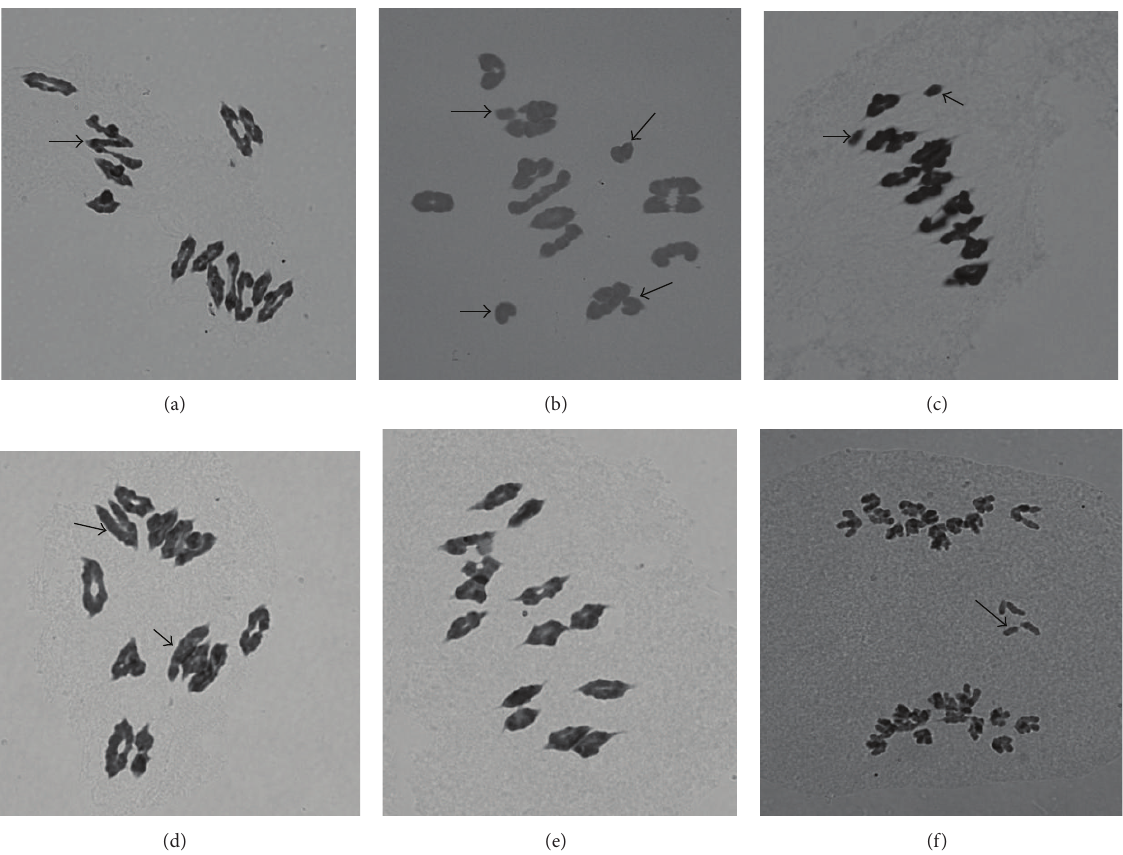
Figure 2: Chromosome pairing at metaphase I in the pollen mother cells. (a) T. dicoccoides (As835) 237-9, with a quadrivalent (arrowed), (b) T. dicoccoides (As835) 237-11, with 4 univalents (arrowed), (c) T. dicoccoides (As838) 239-7, with 2 univalents (arrowed), (d) T. dicoccoides (As838) 239-8, with 2 trivalents (arrowed), (e) T. durum (As781), with 14 rings of the chromosomes, and (f) T. polonicum (As304) 230-7, with lagging chromosomes